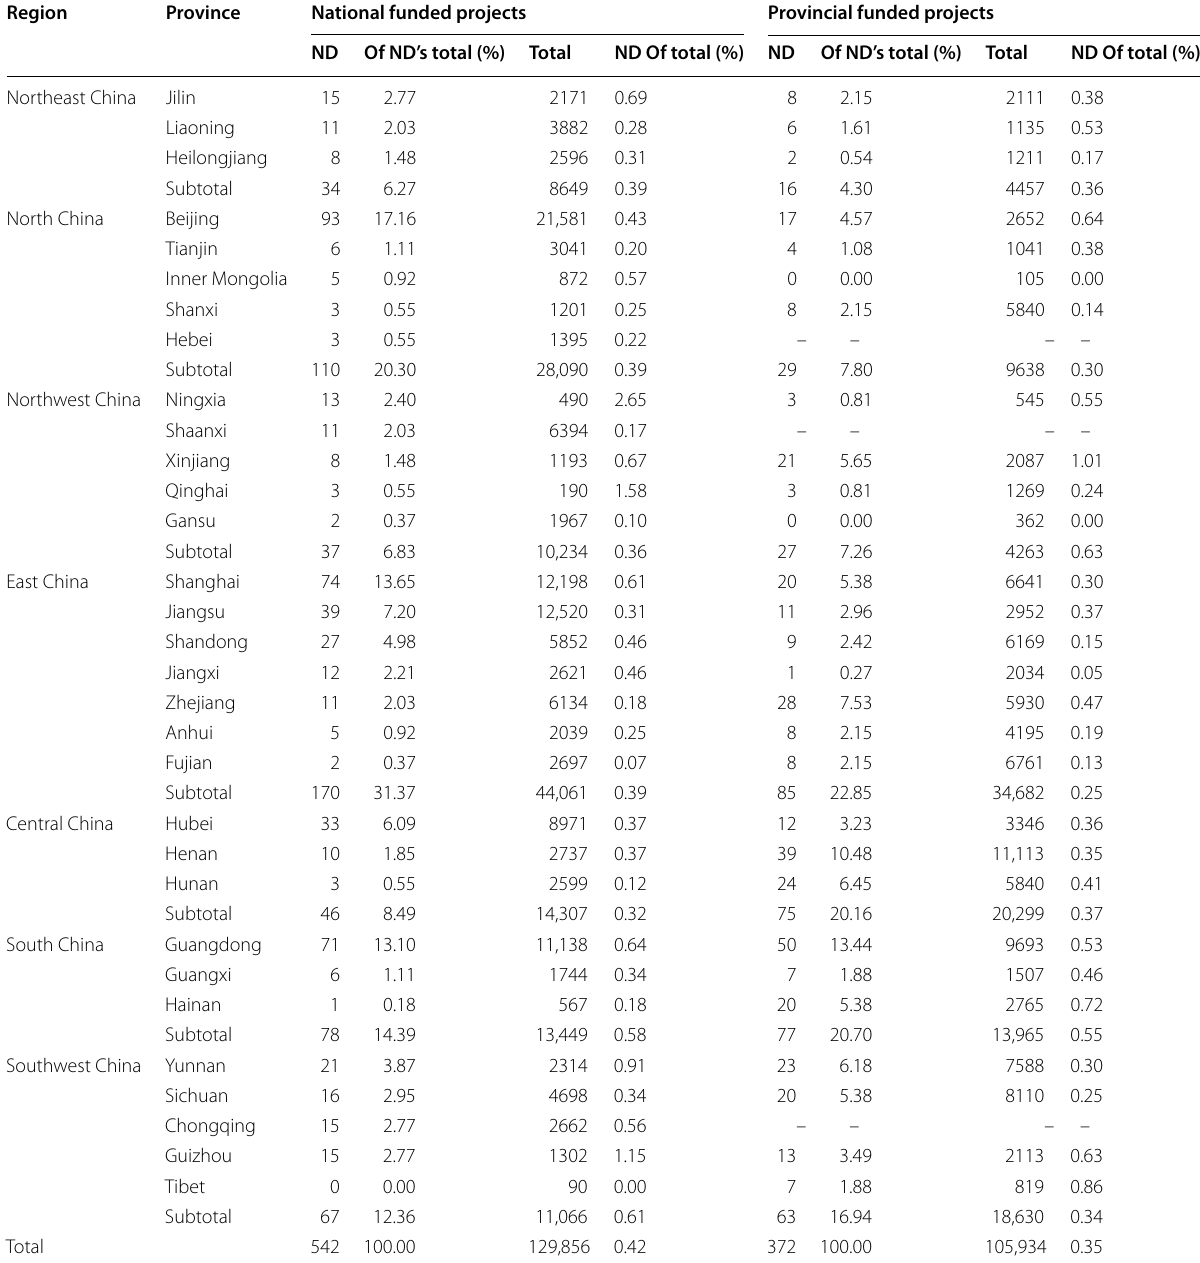
Table 1 Geographical distribution of national- and provincial-funded projects between 2017 and 2019 Region Province National funded projects Provincial funded projects ND Of ND’s total (%) Total ND Of total (%) ND Of ND’s total (%) Total ND Of total